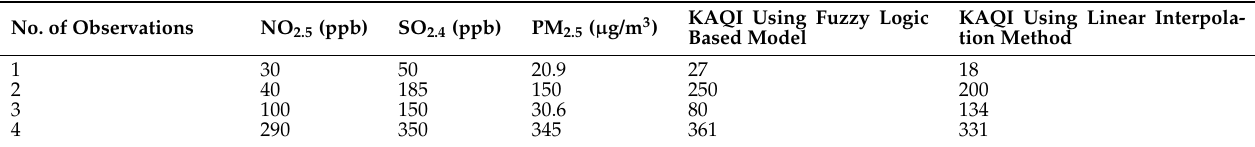
Table 5. Comparative Analysis of KAQI determined by fuzzy logic and linear interpolation methods corresponding to SO 2 , NO 2 and PM 2.5